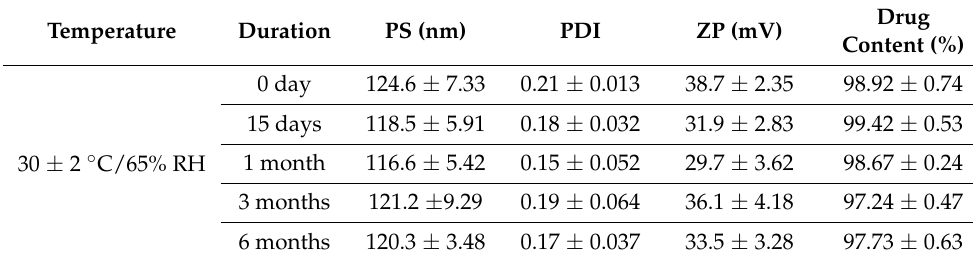
Table 2. Stability assessment of optimized ZTP-ME for 6 months.